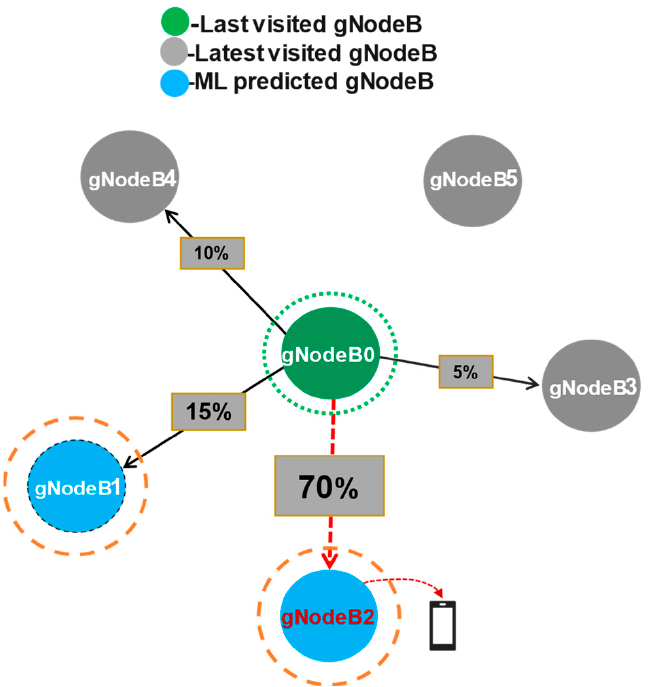
Figure 8. Example of proposed machine learning-based paging.